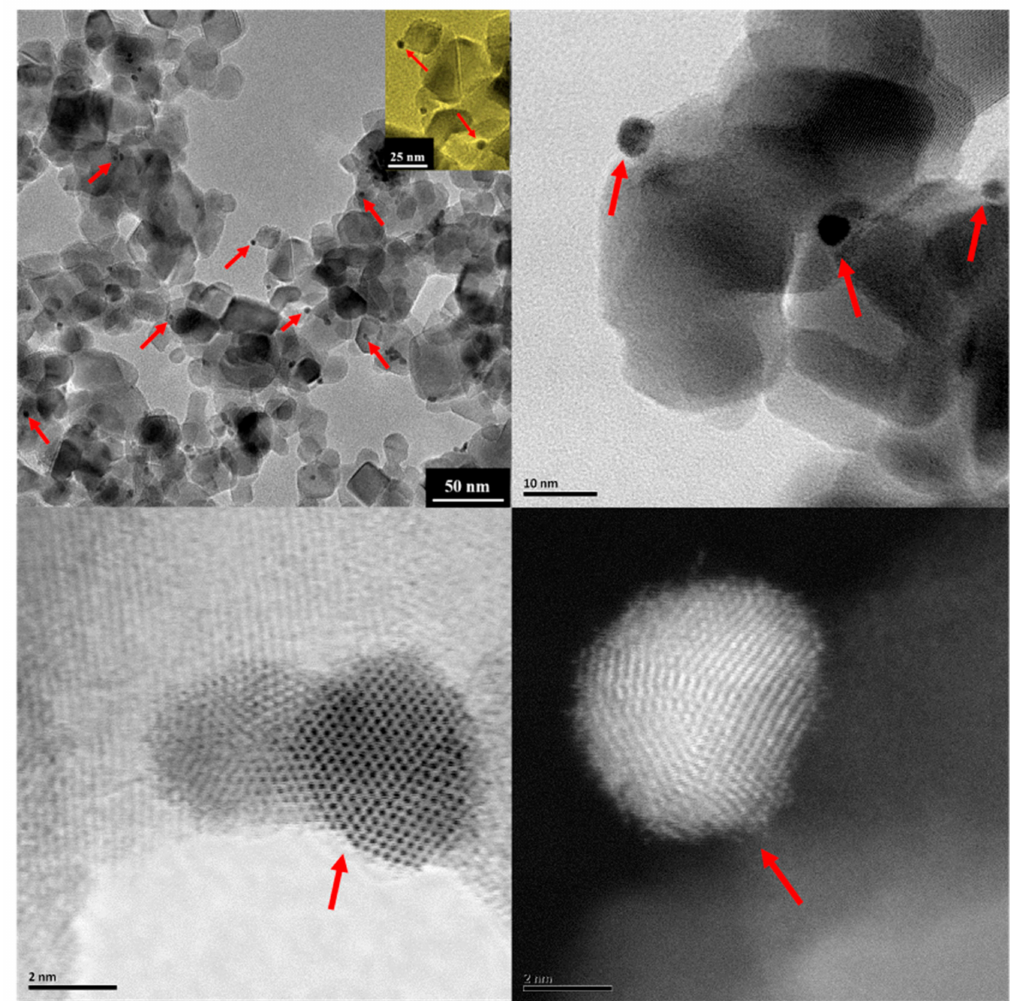
Figure 3. TEM and HRTEM micrograph of P25_is-25Au/75 Pt. The red arrows point to the noble metal nanoparticles, which have an average particle size of 1–4 nm.